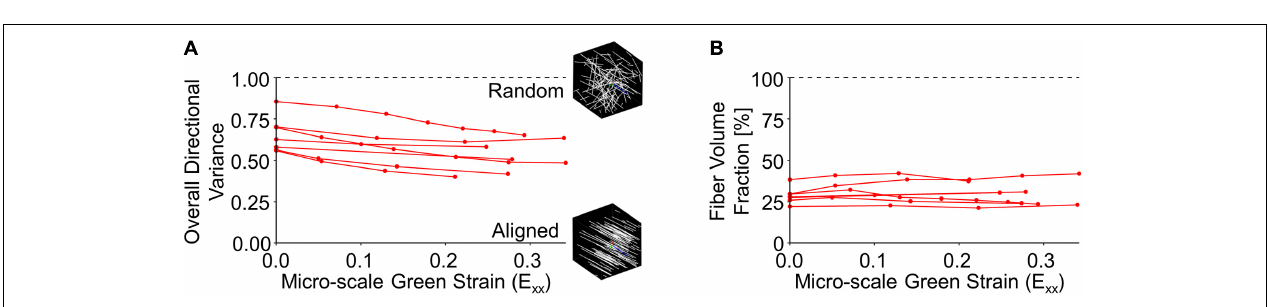
FIGURE 4 | Tissue kinematics measured at multiple length scales were found to experience relatively similar magnitudes of strain and exhibit compressible material behaviors. (A) At the macro-scale, tissue exhibited a very large Poisson’s ratio that was significantly different than expected from an incompressible material. (B) Macro- and micro-scale Green strain for all samples indicates similar tissue deformation across length-scales. (C) Tissue underwent a significant decrease in micro-scale volume during stretch.